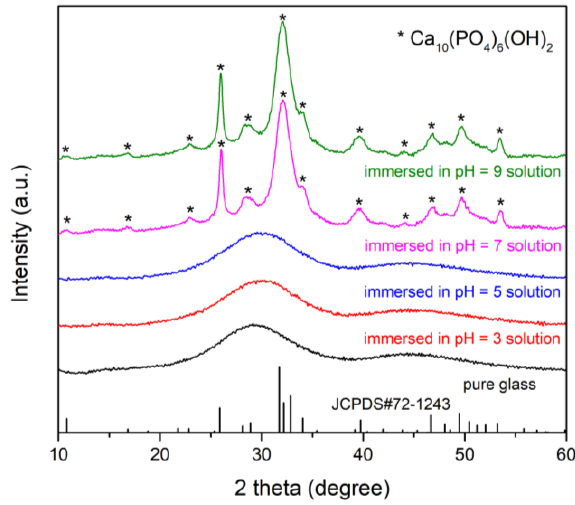
Figure 7. XRD patterns of the glass samples before and after immersion in K 2 HPO 4 solutions with different initial pH for 20 days.